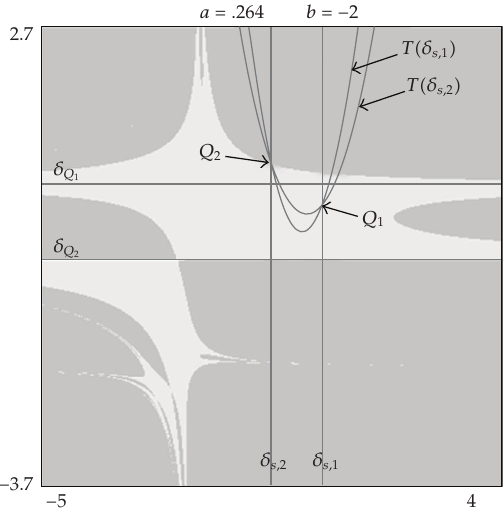
Figure 4: a (cid:2) 0 . 264 basin of attraction